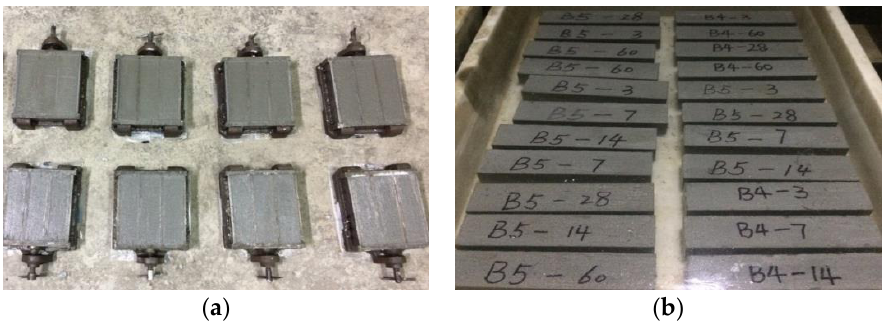
Figure 1. Sample preparation. ( a ) the test blocks in forming; ( b ) the test blocks in curing.